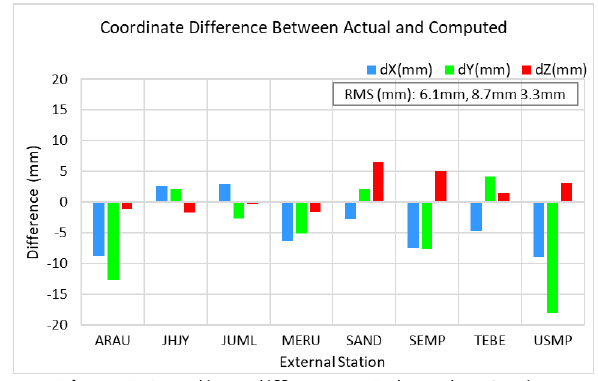
Figure 7 . Coordinate difference at Independent Station (external) after applying the 7p Bursa-Wolf